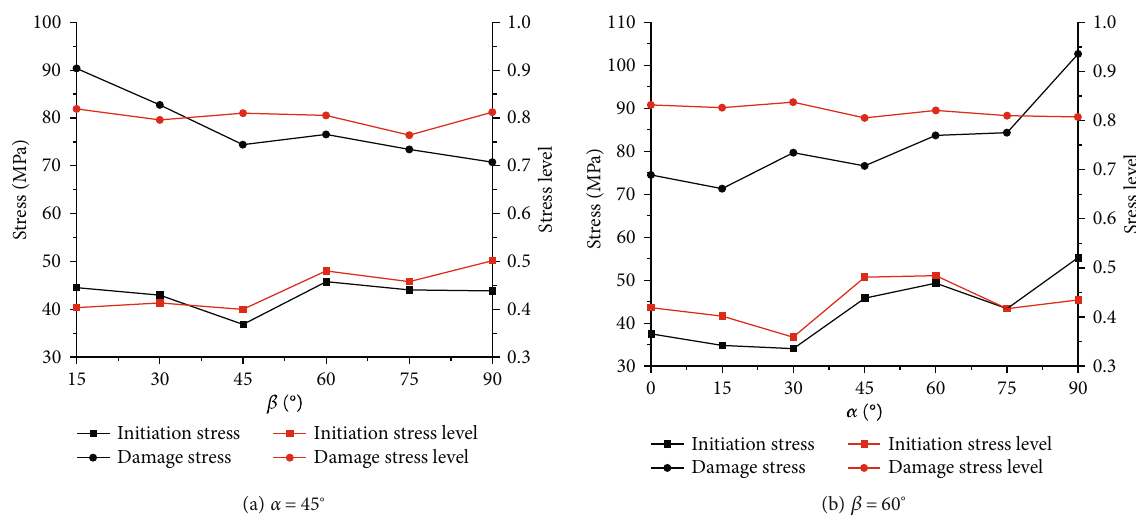
Figure 10: Change curves of crack initiation stress and damage stress of numerical models containing X-shaped fi ssure.